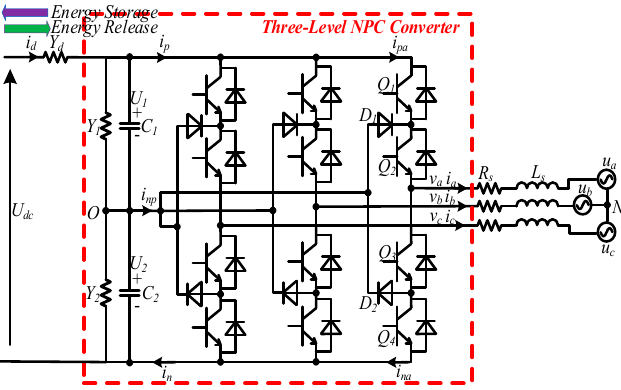
Figure 1. The circuit topology of three-level neutral-point-clamped (NPC) grid-connected converter.